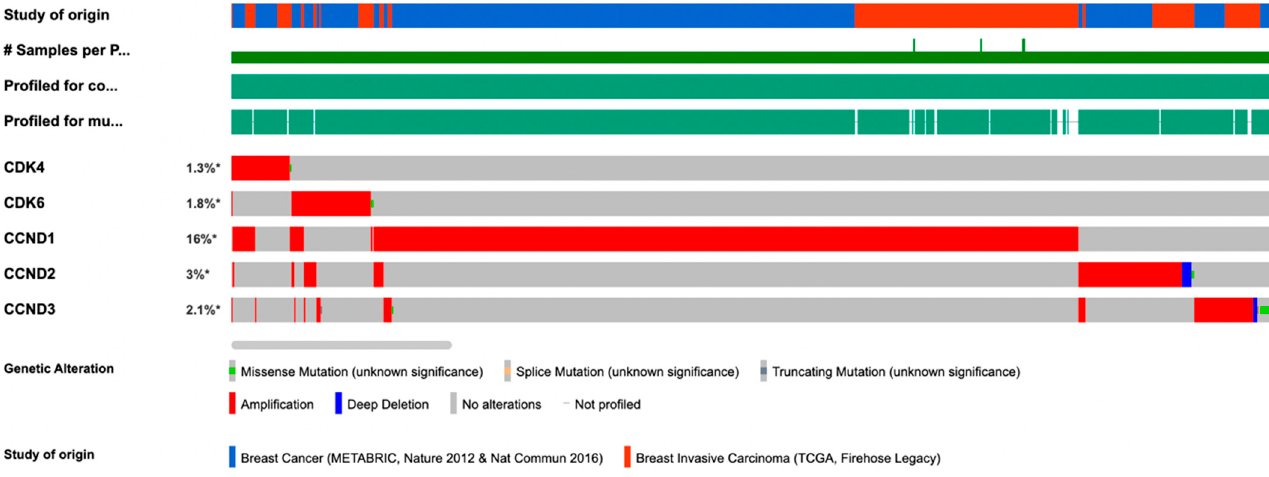
Figure 2. Infrequent CDK4/6 amplification in Breast Cancer therapy. Analysis of 3617 breast cancer samples from CBIOPORTSAL, combining the METABRIC and TCGA (Firehose Legacy data) showed amplification of CDK4 is a rare event (1.3%), co-occurring with cyclin D1 amplification. Frequent amplification of the regulatory subunit of the cyclin D/CDK complexes (cyclin D1, CCND1 ) occurs in human breast cancer. # number of samples. * percentage of patients in the population with the particular genetic abnormality.